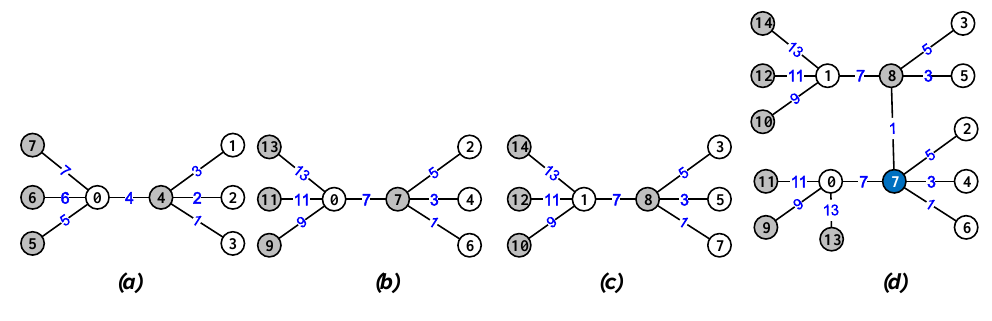
Figure 3. Examples for illustrating Corollary 2. ( a – d ) are T , T (cid:48) , T (cid:48)(cid:48) , and T (cid:48) (cid:5) T (cid:48)(cid:48) ,